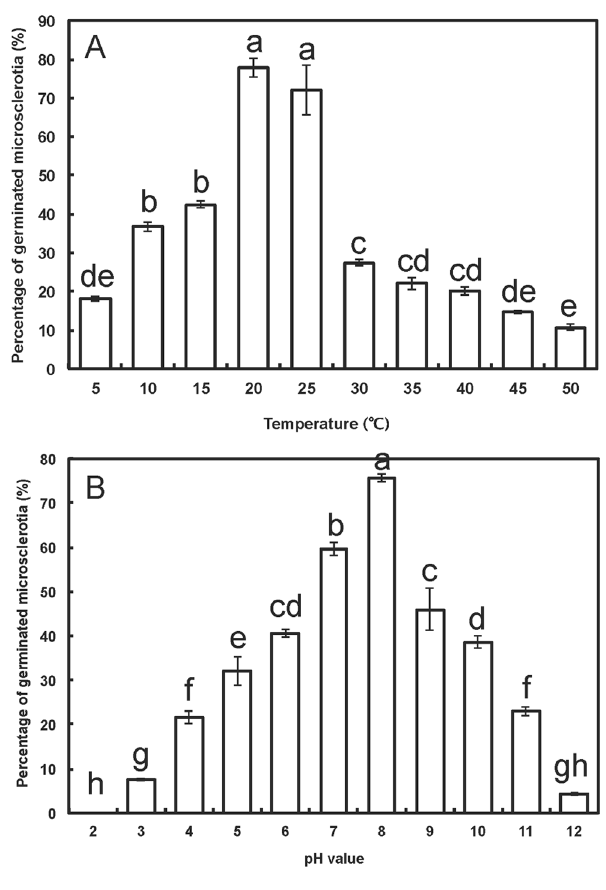
Figure 2. Percentage of germinated Verticilliumdahliae micro- sclerotia after 16 h incubation in darkness at different temperatures (A) and pH (B). Data are shown as the mean of three replicated expriments. Bars represent standard error (SE) of means. Bars marked with different letters (lowercase) are significantly different ( P ,